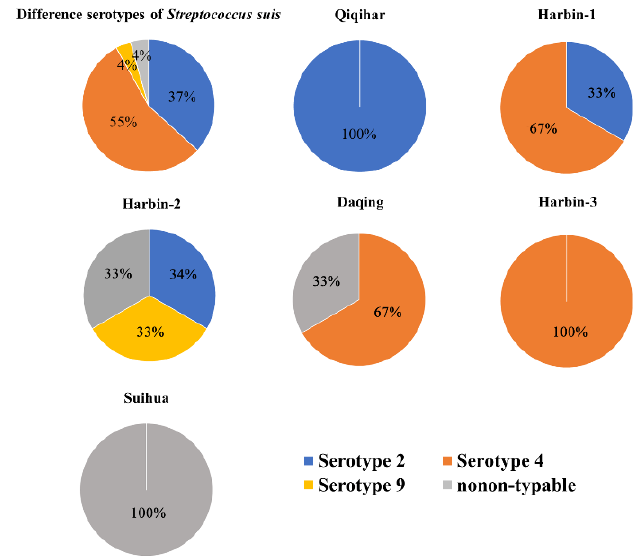
Figure 2. Percentage isolation rate of the different serotypes of S. suis isolated from the six farms. S. suis 2 were 34.48%, S. suis 4 were 51.72%, S. suis 9 were 3.45%, and S. suis with no serotype were 10.35%. Only one serotype existed in the farms located in Qiqihar, Harbin-3, and Suihua. The farms in Harbin-1 and Daqing had two serotypes. Three serotypes were isolated the farm located in Harbin-2.